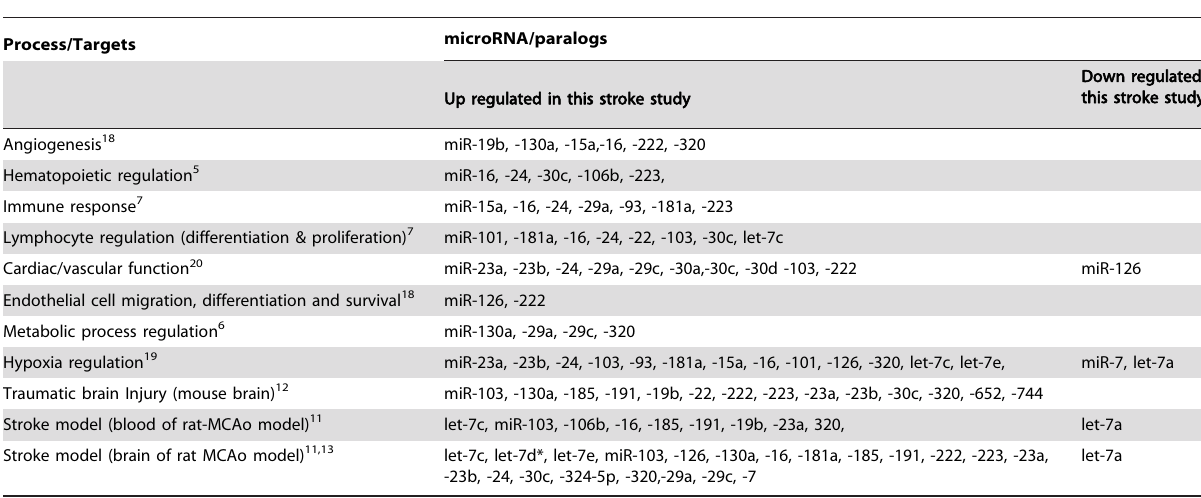
Table 4. microRNAs and their target biological